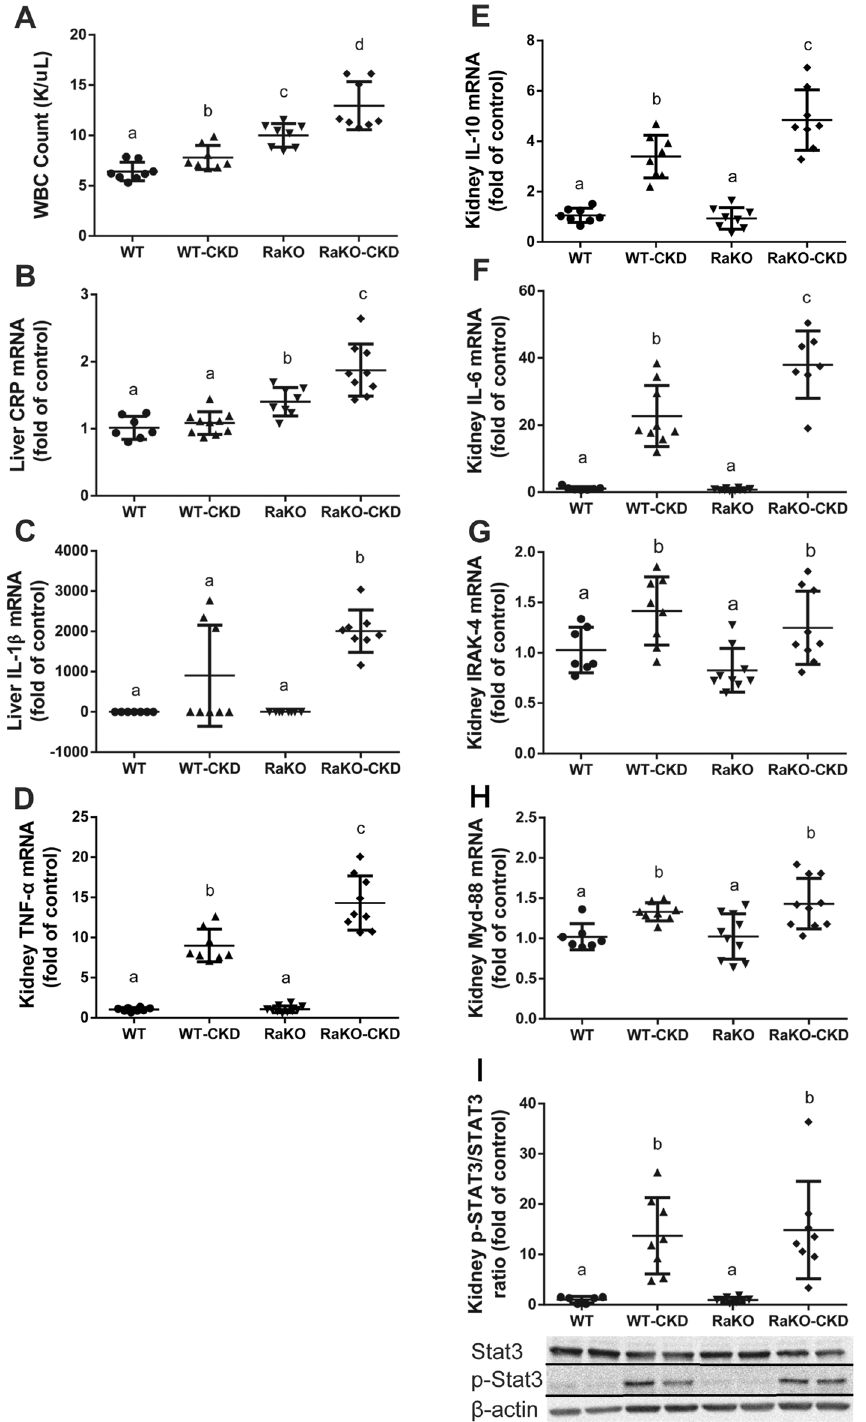
Figure 2. Systemic inflammation of CKD mice with uncontrolled IL1 expression. Experimental groups include: wild type mice on a regular (WT) or adenine diet (WT-CKD), IL1-R antagonist knockout mice on regular diet (RaKO) or adenine (RaKO-CKD). White blood cell count (K/uL) (A). Liver C-reactive protein (CRP) (B) and Interleukin-1 β (IL-1β) (C) mRNA levels. Kidney TNF-α (D) , Interleukin-10 (IL10) (E), Interleukin-6 (IL6) (F) , IRAK-4 (G) and MYD-88 (H) mRNA levels. Kidney p-STAT3/STAT3 protein ratio (corrected for β-actin). The lower panel shows a representative gel (I) . n = 7–10 per group. Different letters above bars indicate a significant difference between groups, similar letters indicate no significant